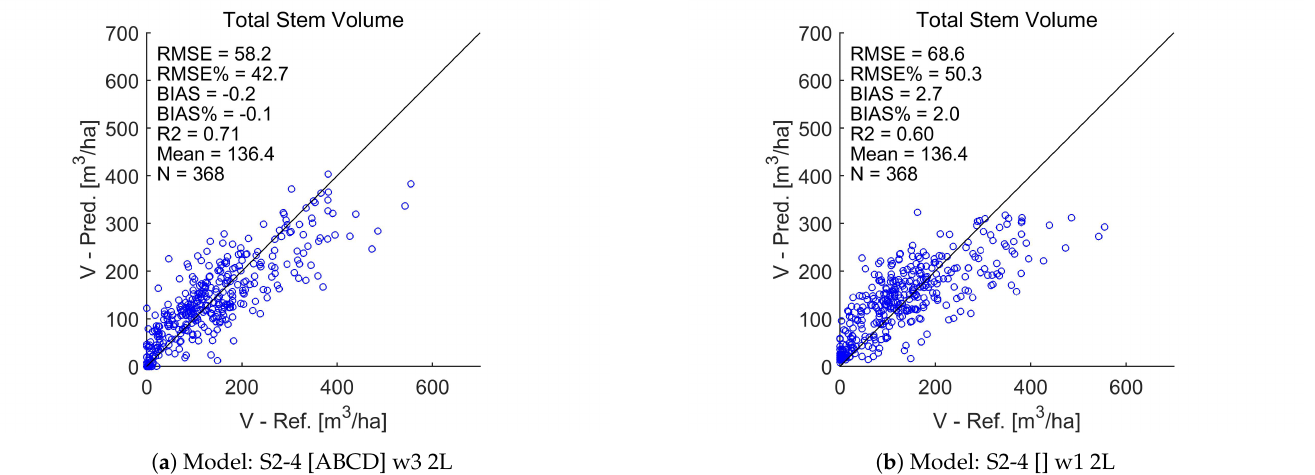
Figure 10. Scatterplots of total stem volume test data set predictions with the proposed model concept ( a ) and with the simple model ( b